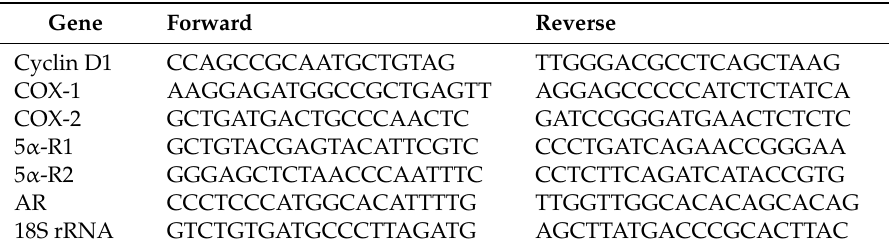
Table 1. Primer sequences used for real-time